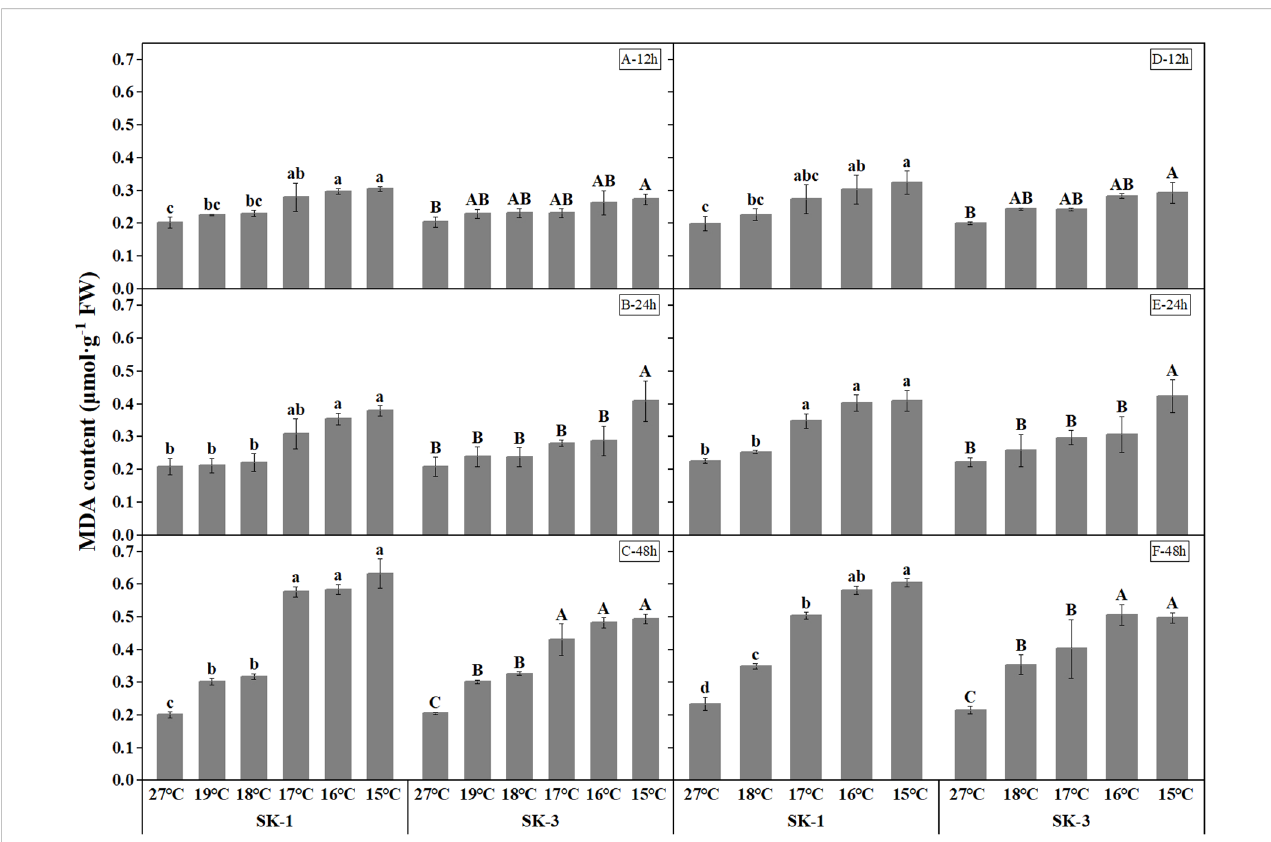
FIGURE 4 Effect of low temperature stress on MDA content in cotton squares in 2020 ( A-C : 12h, 24h, 48h stress) and 2021 ( D-F : 12h, 24h, 48h stress). FW represents fresh weight.Different lowercase letters indicate the signi fi cant differences between the treatments of the variety SK1, and different capital letters indicate the signi fi cant differences between the treatments of the variety SK3